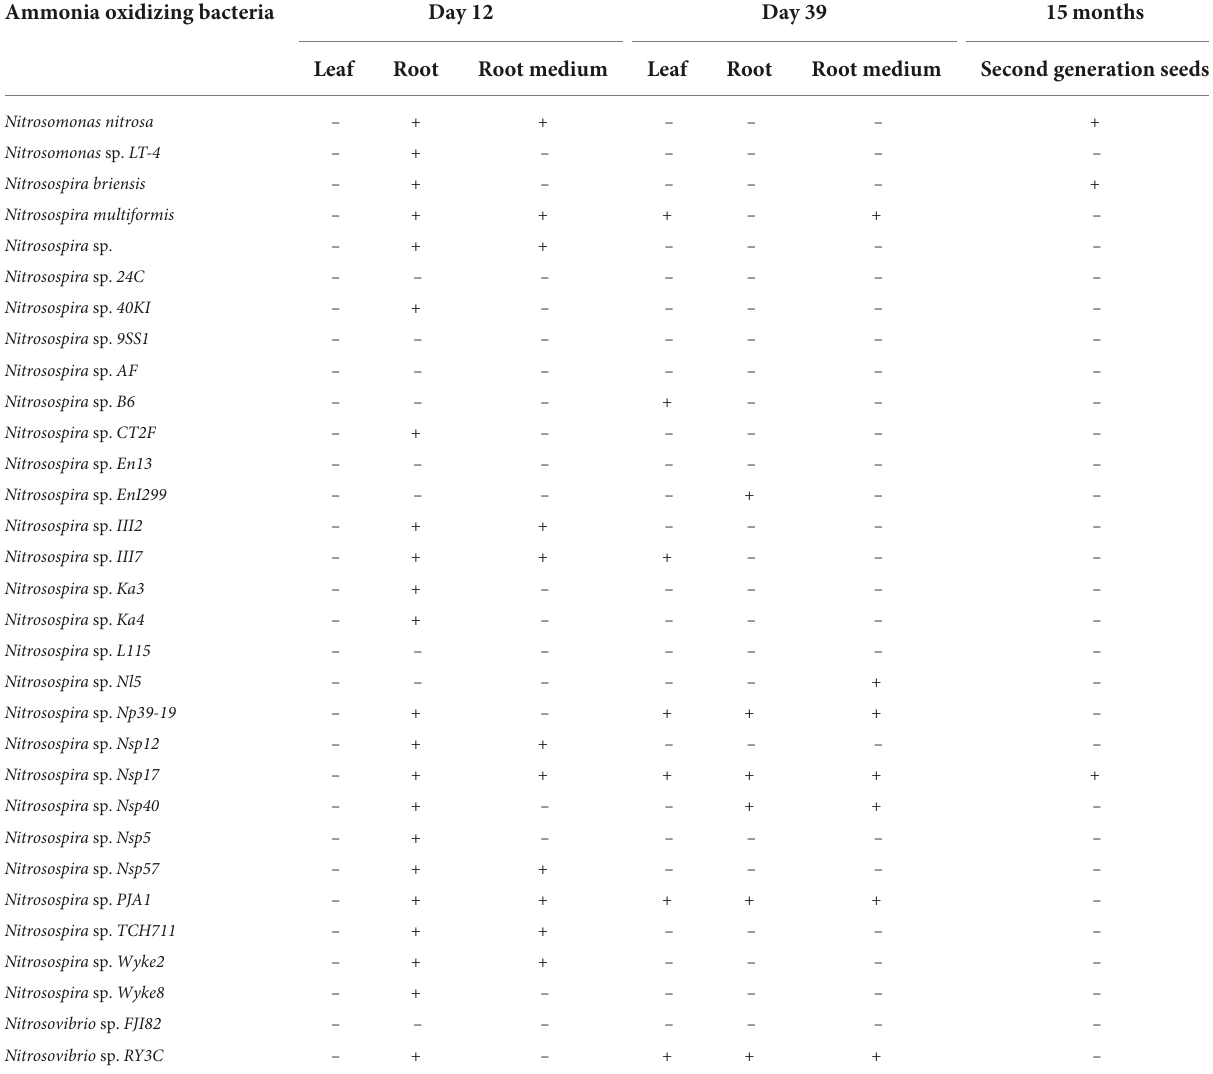
TABLE 1 The transmission of ammonia oxidizing bacteria in Elymus nutans seeds to leaf, roots, root medium of offspring plants at 12 and 39 days and